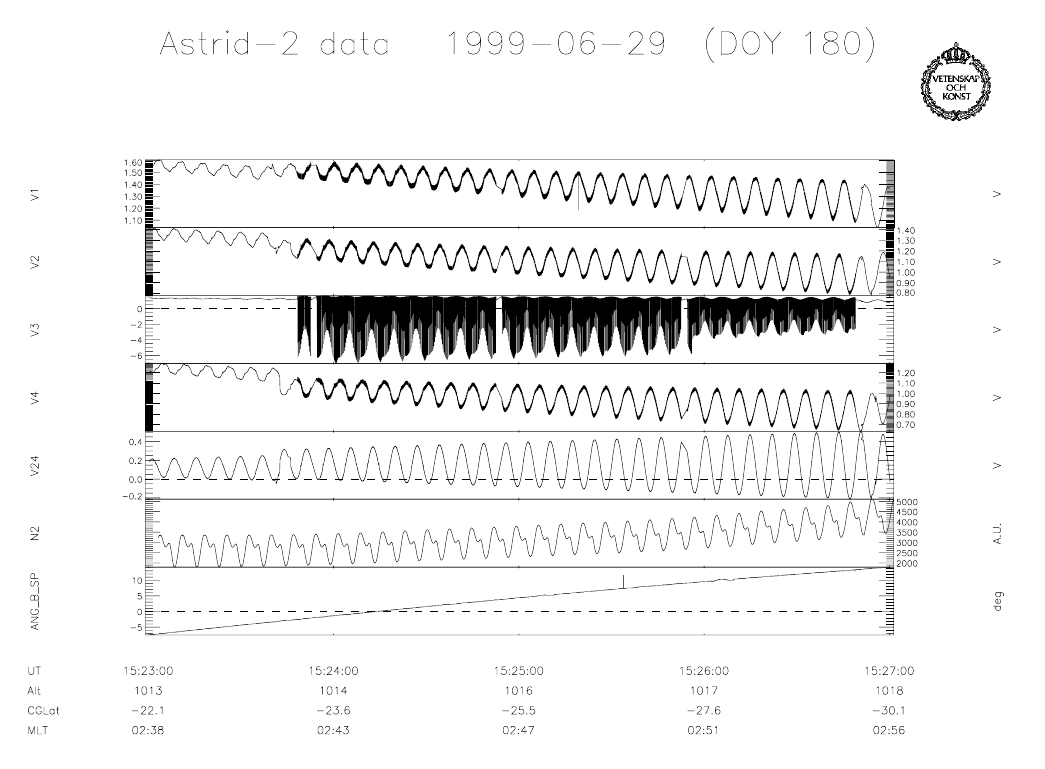
Fig. 11. EMMA measurements on 29 June 1999. The format is the same as in Fig. 5.